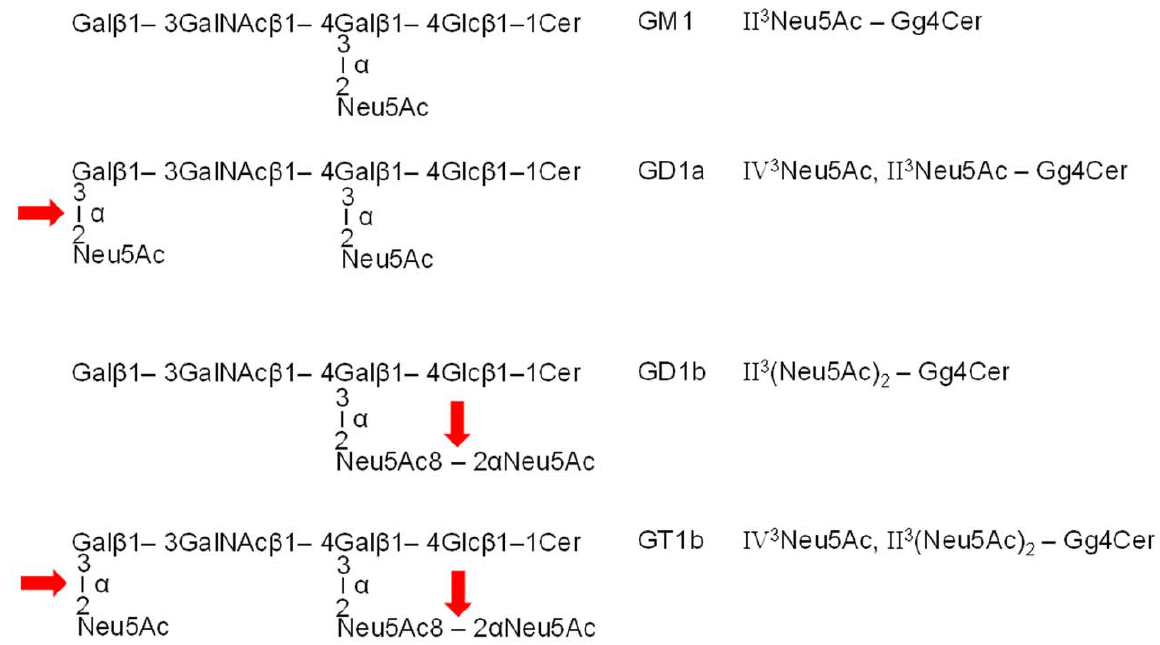
Figure 1. Structures of ganglio-series gangliosides GM1, GD1a, GD1b, and GT1b. The red arrows indicate the neuraminidase-sensitive positions of Neu5Ac terminally linked in α 2-3-configuration to the distal galactose at position IV of GD1a and GT1b and the α 2-8-linked outer Neu5Ac of the disialo-group of GD1b and GT1b at the proximal galactose at position II of the Gg4Cer core. For